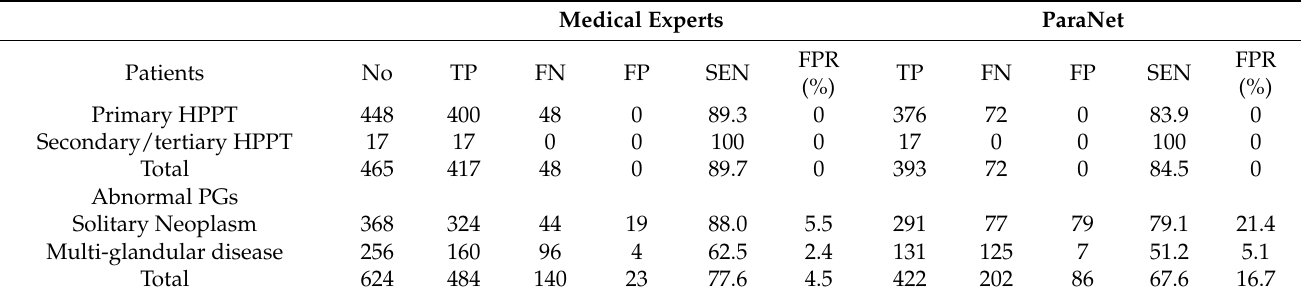
Table 9. Scintigraphic results according to the medical experts’ diagnosis and the ParaNet model in 256 operated patients with positive surgical findings in the